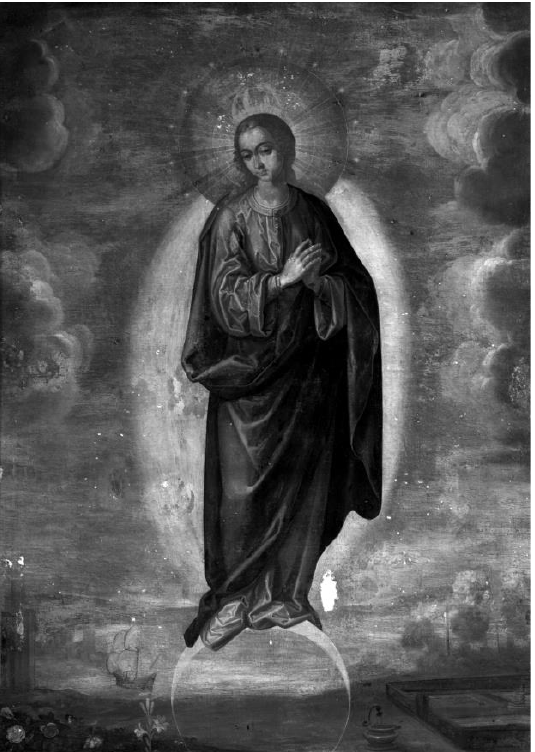
Figure 4. IRR image of La Inmaculada, confirming several retouched areas, the use of different pigments, underdrawing on the half-moon, and the change in the form of the architecture on the right.